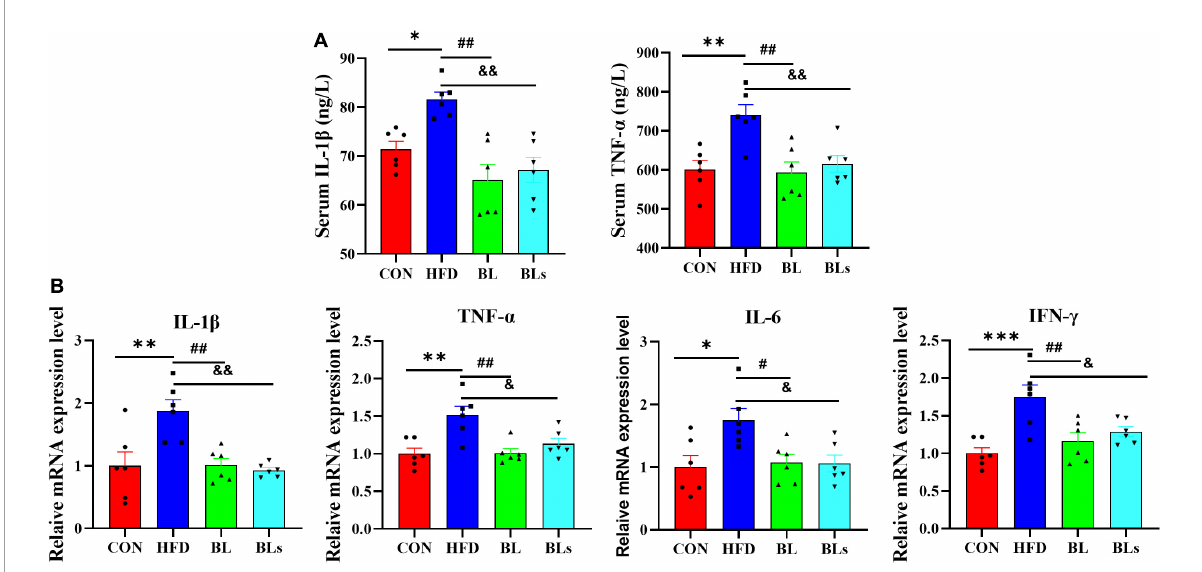
FIGURE3 Brevibacillus laterosporus BL1 treatment alleviated the secretion of proinflammatory cytokines in HFD-fed mice. (A) Serum levels of IL-1 β and TNF- α , (B) relative mRNA expression levels of IL-1 β , TNF- α , IL-6, and IFN- γ were determined using real-time PCR in the liver. Data are presented as mean ± SEM ( n = 6) and analyzed using one-way ANOVA. Significant differences between HFD and CON are indicated by ∗ p < 0.05, ∗∗ p < 0.01, and ∗∗∗ p < 0.001. Significant differences between HFD and BL are indicated by # p < 0.05 and ## p < 0.01. Significant differences between HFD and BLs are indicated by & p < 0.05 and && p < 0.01.